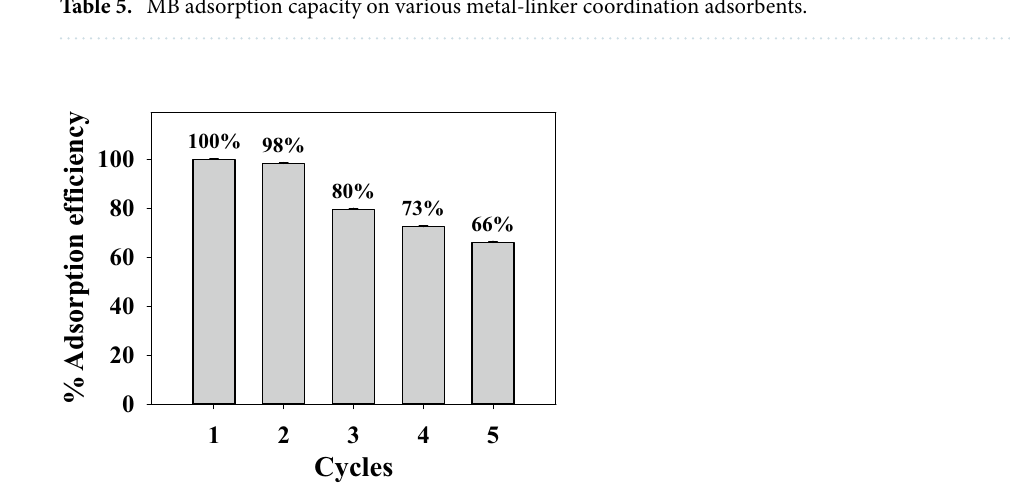
Figure 8. The adsorption efficiency of N g -CuGA for the MB removal after five adsorption–desorption